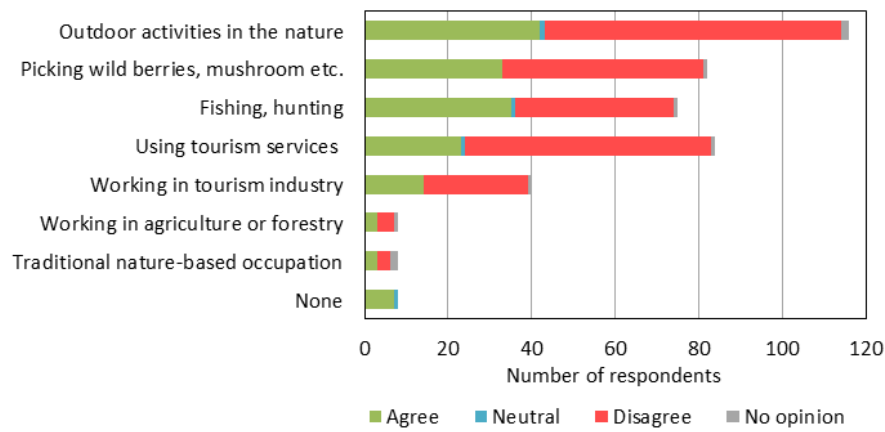
Figure 6. Relationship between respondents’ activities in the region and opinion on the statement “New mining activities would be welcome in the closed mining areas . ”